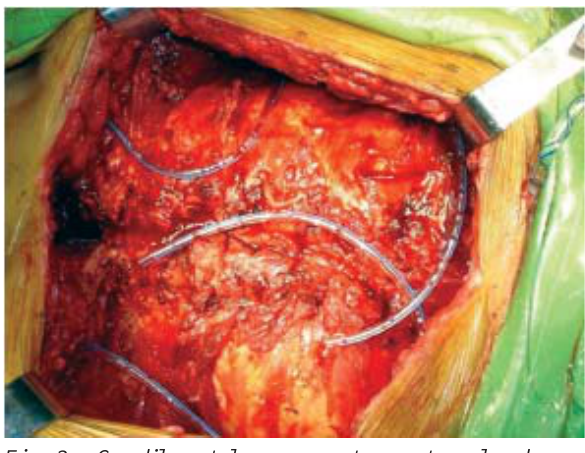
Fig. 3 - Gradil costal com ressutura esternal e drenos posicionados,por sobre o gradil costal. Tecido